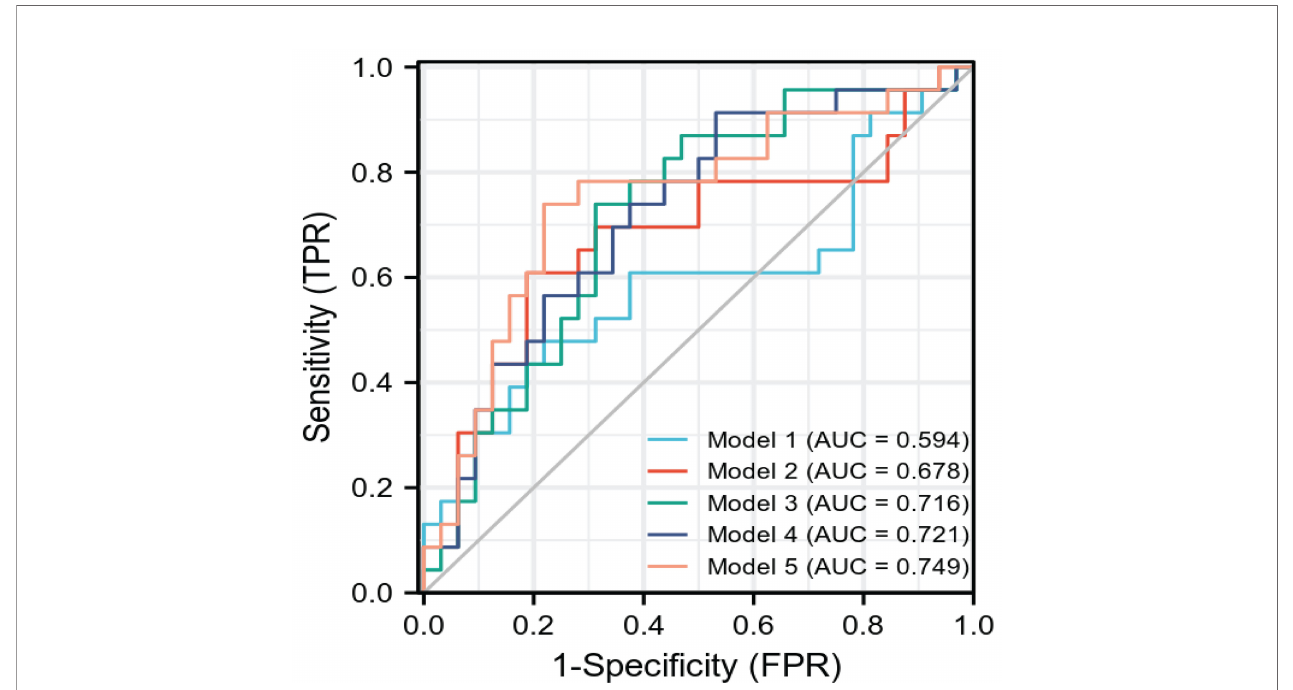
FIGURE 3 | The ROC curve of each model radiomics model. AUC is the same as Table 2 . ROC, receiver operating characteristics.